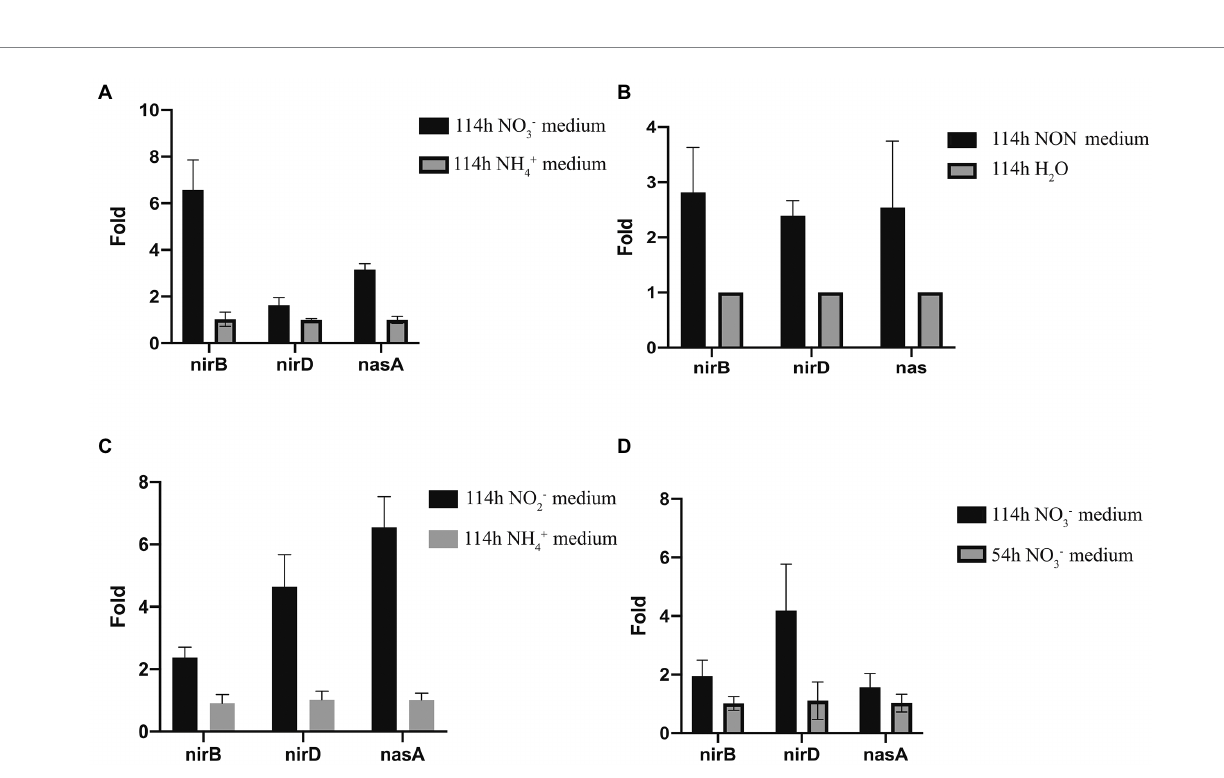
FIGURE 7 Quantitative PCR analysis of nirB, nirD, and nasA expression of strain 24S4–2 grow in a different mediums. (A) strain 24S4–2 grow in medium with nitrate or ammonium as the sole nitrogen source, (B) strain 24S4–2 grow in nitrogen-free medium (NON) and water, (C) strain 24S4–2 grow in medium with nitrite or ammonium as the sole nitrogen source, and (D) strain 24S4–2 grown in medium with nitrite as the sole nitrogen source for 114 h or 54